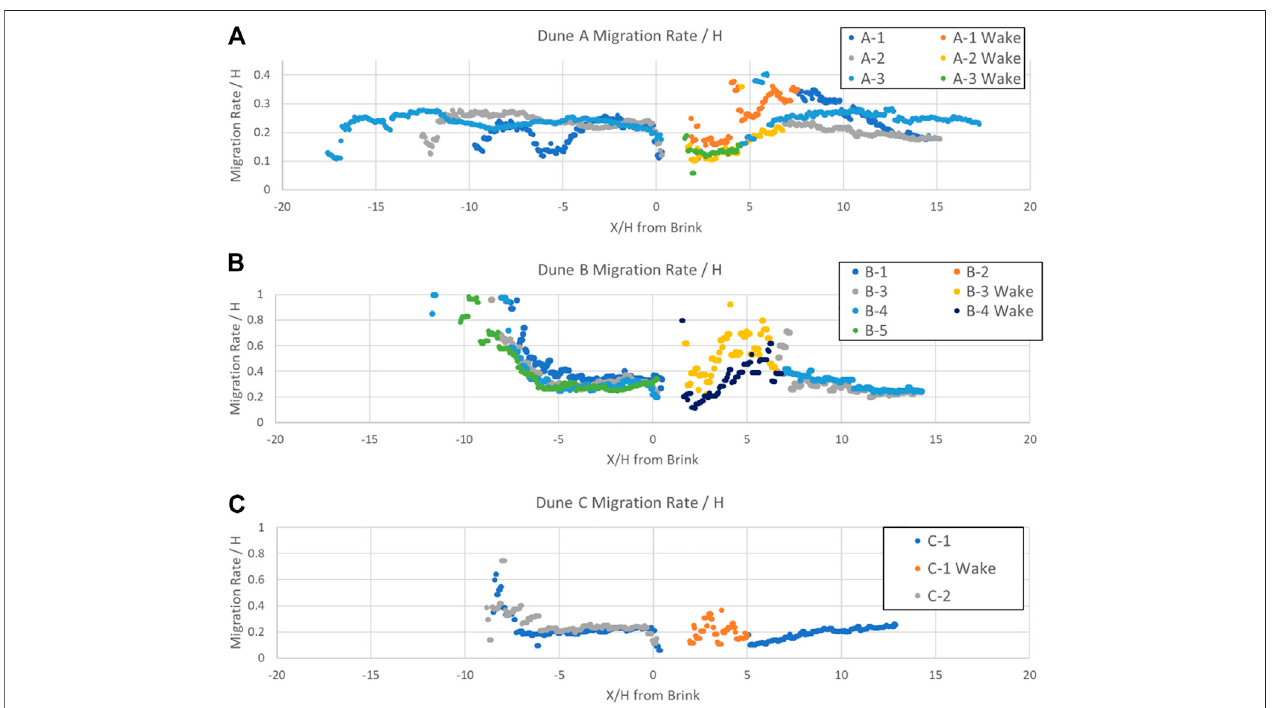
FIGURE7| RippleMigrationRate/H(R/H)forselectedtransectsalongDunes (A-C) withareasmappedaswakeshighlightedincaseswherethetransectcrossesa wake.Mosttransectsshowasimilarpattern:DunestossslopesreachaconstantR/Hwithin3 – 4brinkheightsoftheupwindsideoftheduneandareasmappedaswake ripplesgenerallydeviatefromthisstossslopepattern.InDune (A) ,thewakezones appearasextended areasofrisingR/H,extendingbetween4and7 Hfromthebrink. In Dune (B,C) , thewakezones show somerampup, but alsoshow ahigher R/H thanthe stoss slopeofthetrailing dune. Asshown in Figures2 , 3 ,thefront ofthe leading dune in dunes B and C falls close to the datum used to calculate dune height, leading to the high R/H values at the front of those dunes.